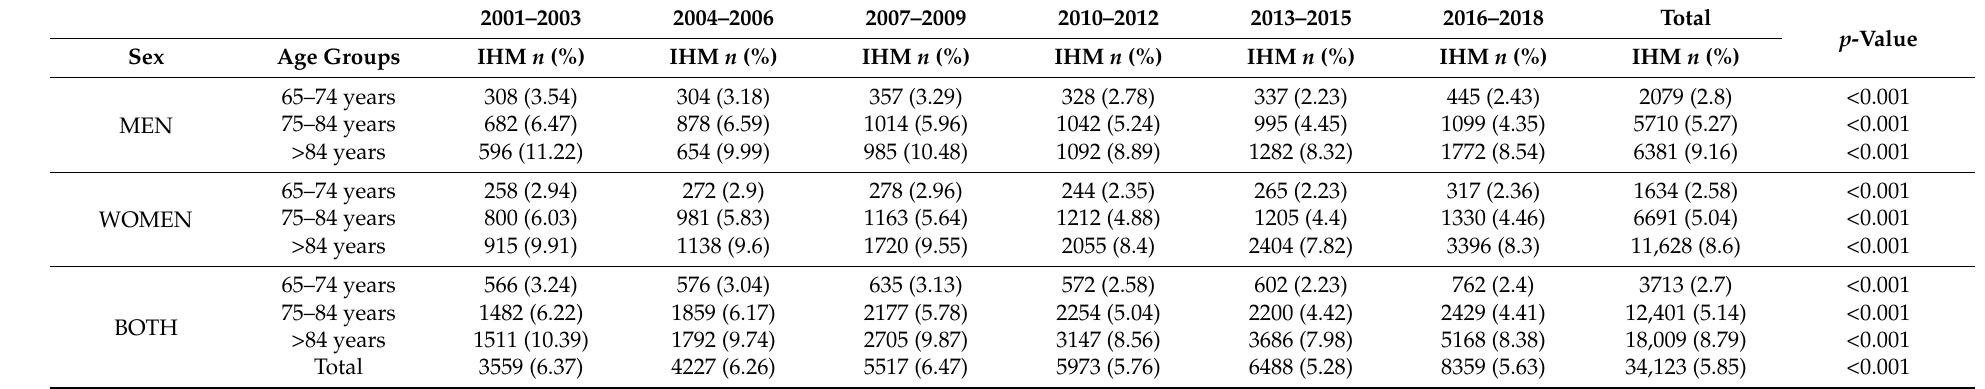
Table 4. Trends in the in-hospital mortality among elderly patients admitted to hospital with a principal diagnosis of urinary tract infection according to age groups and sex in Spain